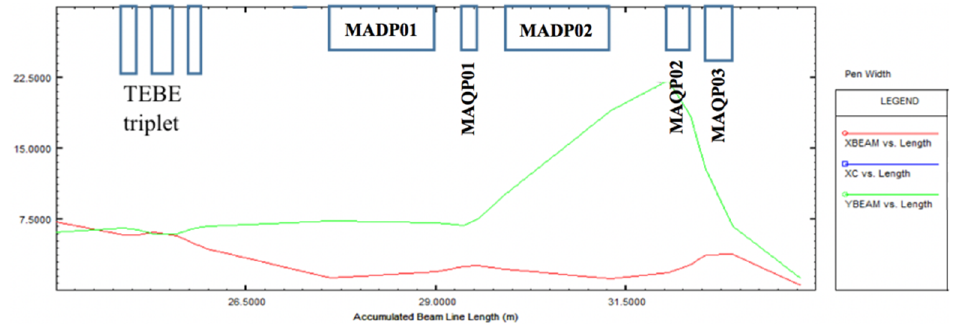
Figure 5. Beam envelope (mm) as a function of the transport beam line length (m) inside the MAGNEX area.